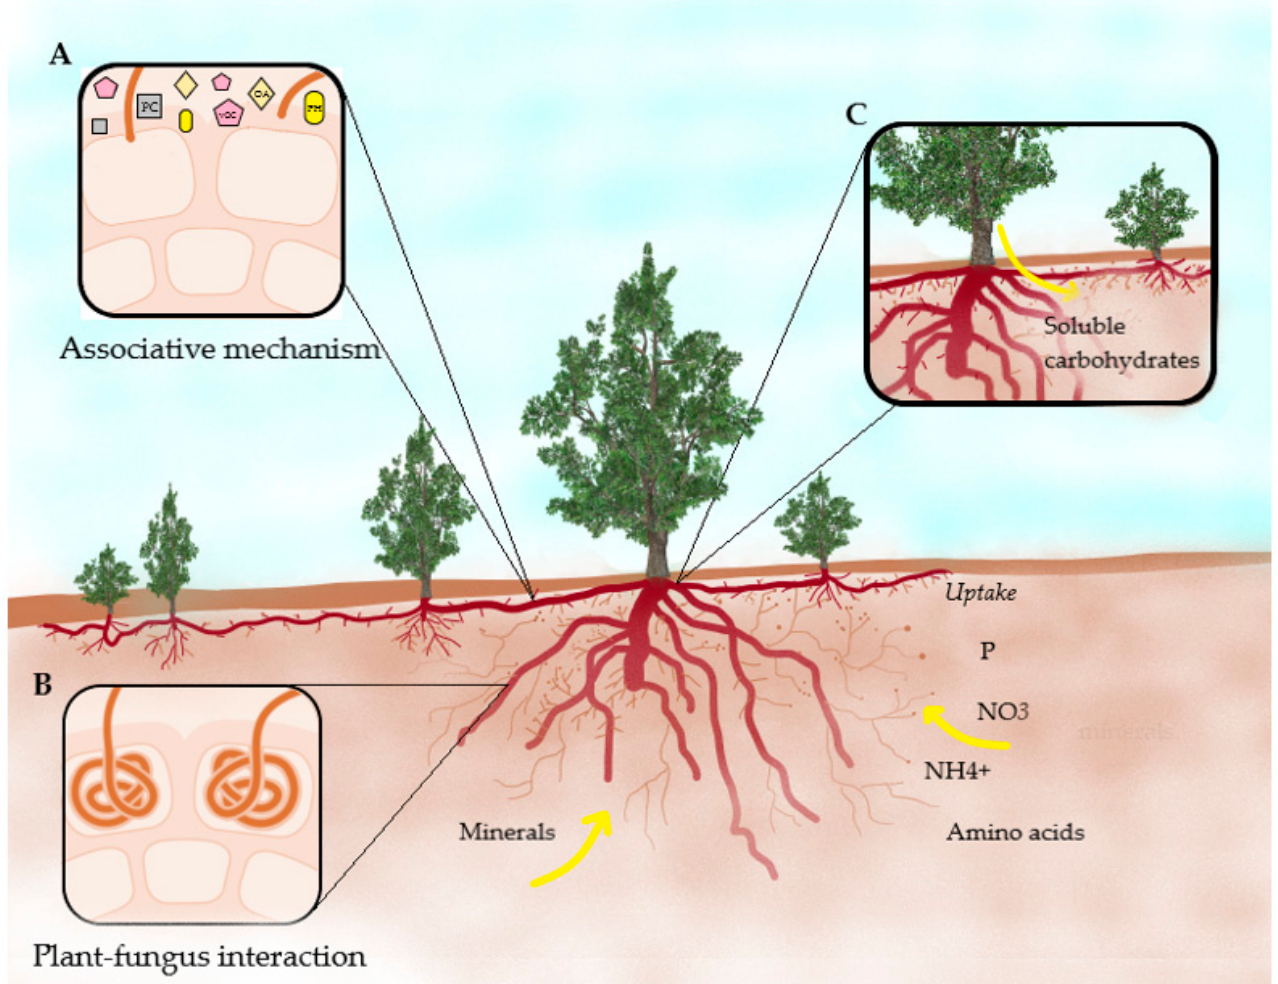
Figure 3. Schematic diagram of ericoid mycorrhizal interaction between plants and fungi according to their mechanisms. ( A ) Recognition mechanism of an associated fungus for the formation of mycorrhizae; ( B ) establishment of the plant–fungi association; and ( C ) transfer of soluble carbohydrates from plant to fungus. PC: phenolic compounds, VOC: volatile organic compounds, OA: organic acids, PH: phytohormones.